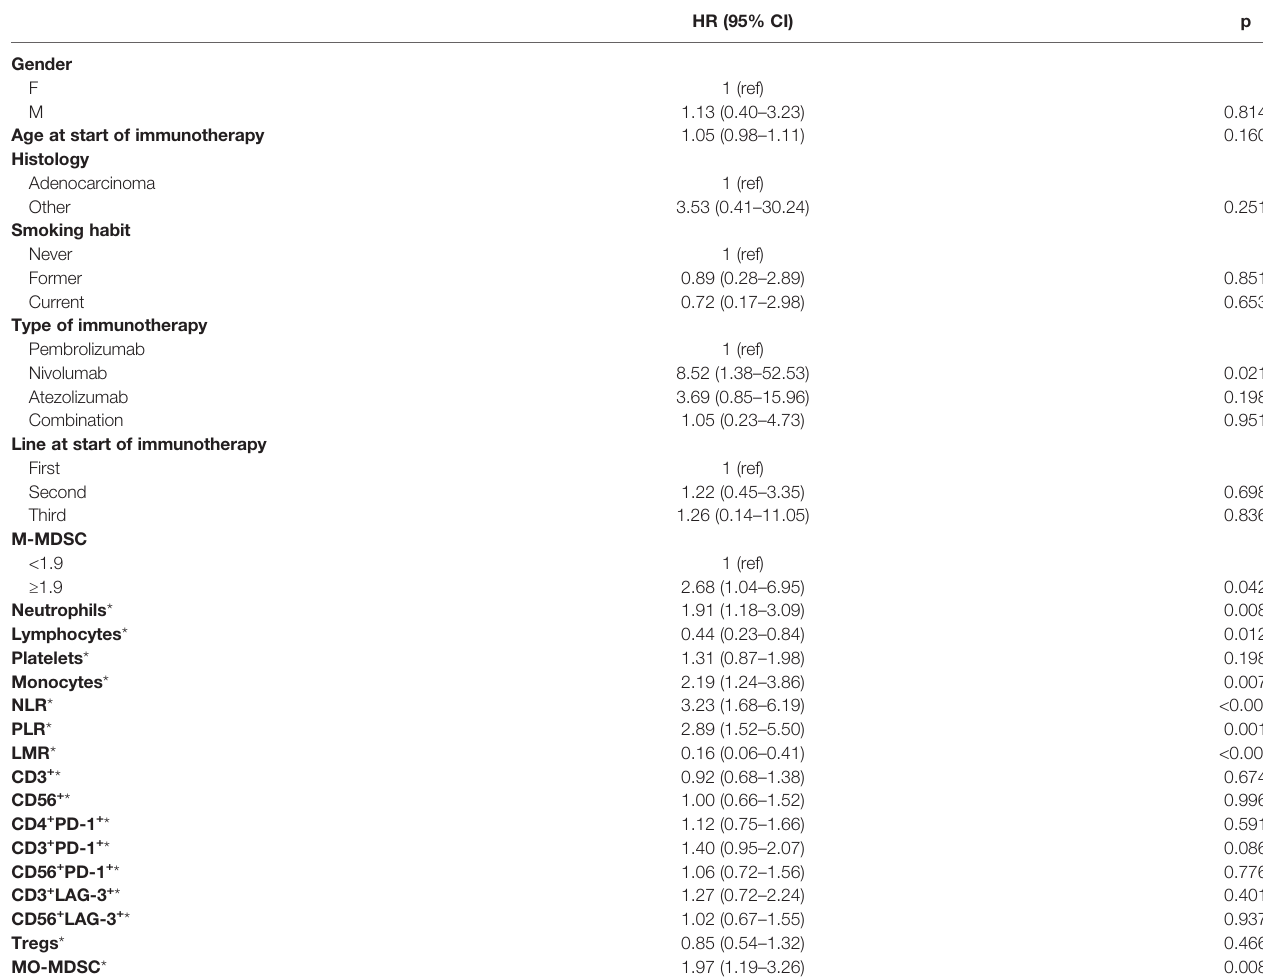
TABLE 3 | Univariate analysis for